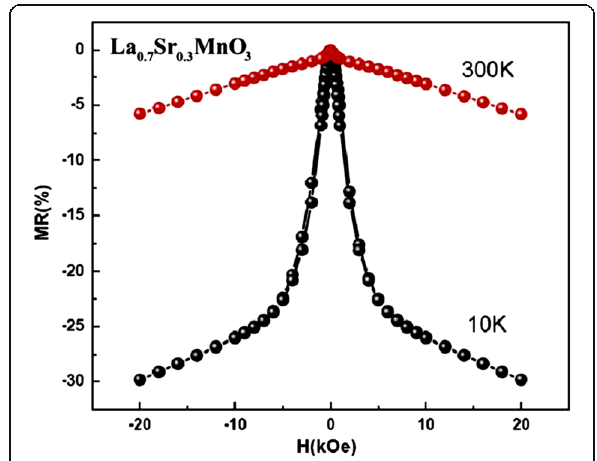
Fig. 24 Magnetic field dependence of the MR curves from − 20 to 20 kOe at 10 K and 300 K for the La 0.7 Sr 0.3 MnO 3 nanoparticles. Reproduced with permission of